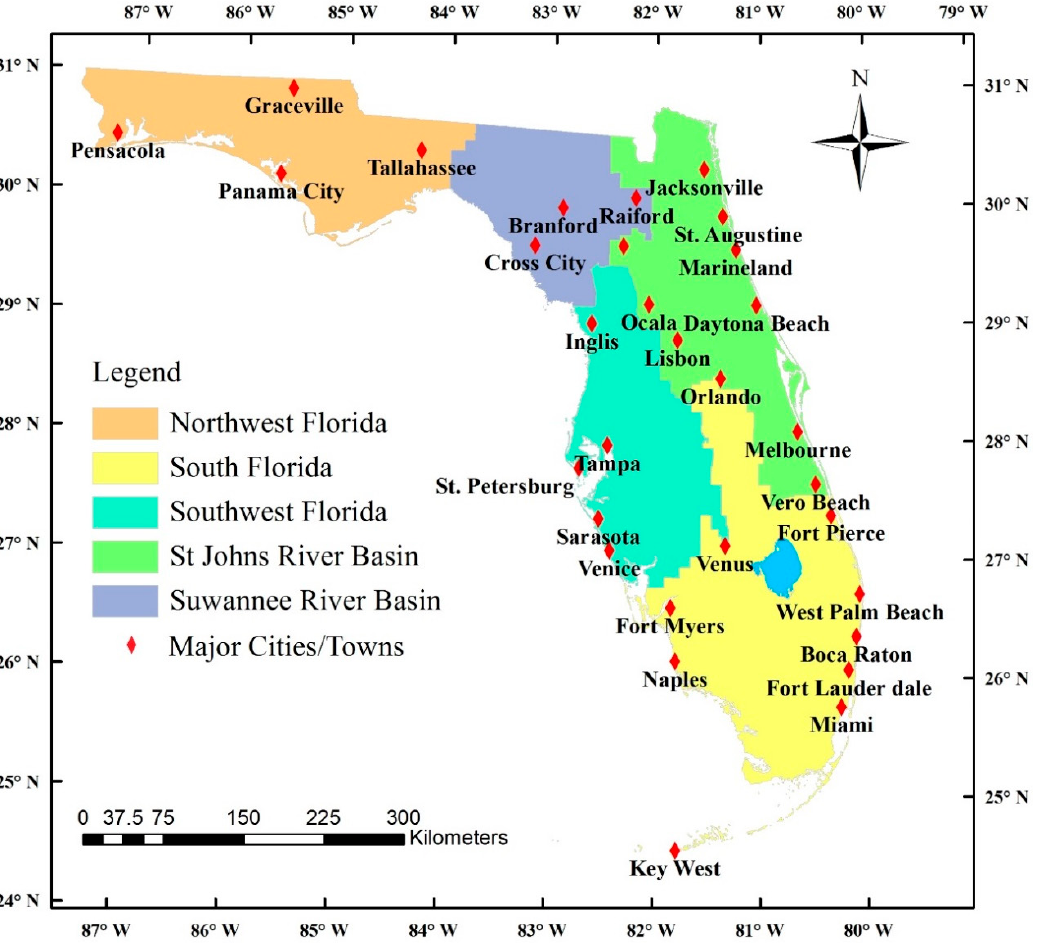
Figure 2. The major cities and towns of mainland Florida. The legend describes the five major water management districts of Florida.